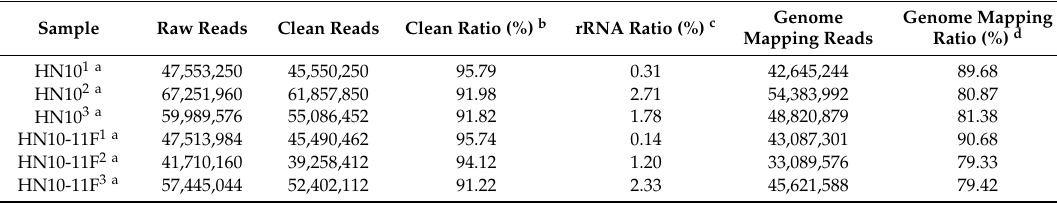
Table 1. Summary of sequencing data.